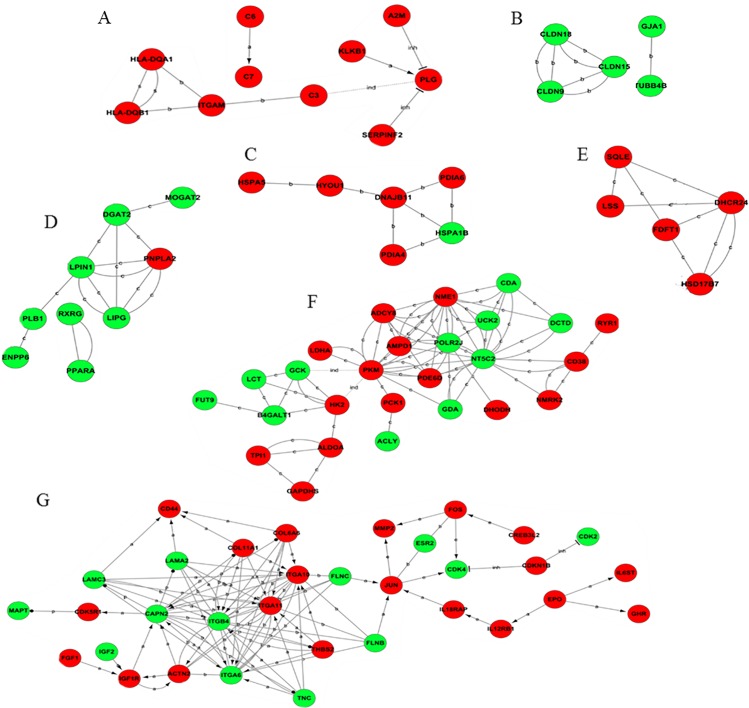
Gene act subnetworks in the 0 vs 16 psu categories.(A): complement and coagulation cascades; (B): cell connection; (C): endoplasmic reticulum activity; (D): fat digestion and absorption; (E): steroid biosynthesis; (F): glycolysis/gluconeogenesis; (G): signal transport. The red ball represents the up-regulated genes, while the green ball represents the down-regulated genes. The connections of genes were generated from the data analysis comprising GO analysis and KEGG pathway. The solid lines represent the relationships between genes. The dashed lines represent the genes that have an indirect effect. The arrow represents activation. The flathead represents suppression. ‘a’ represents activation; ‘b’ represents binding; and ‘c’ represents compound.